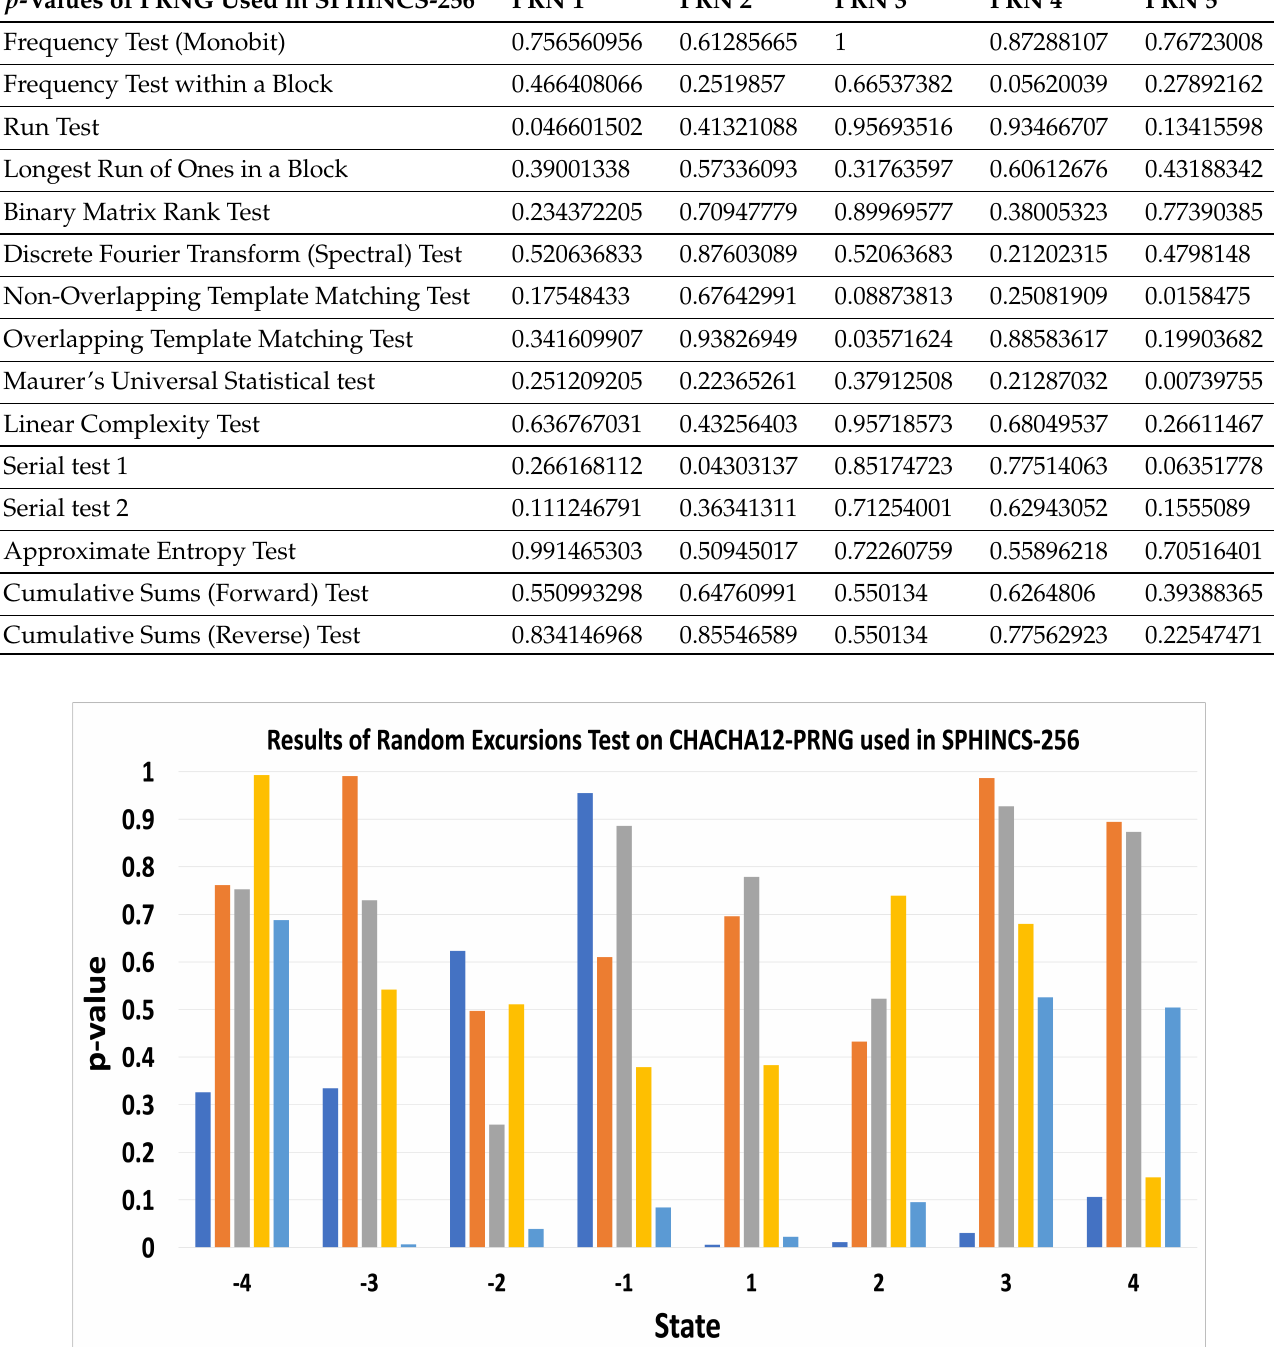
Table 8. p -values of appropriate NIST Statistical Tests for Random and PRNG applied on Chacha-12 used in SPHINCS-256. p -Values of PRNG Used in SPHINCS-256